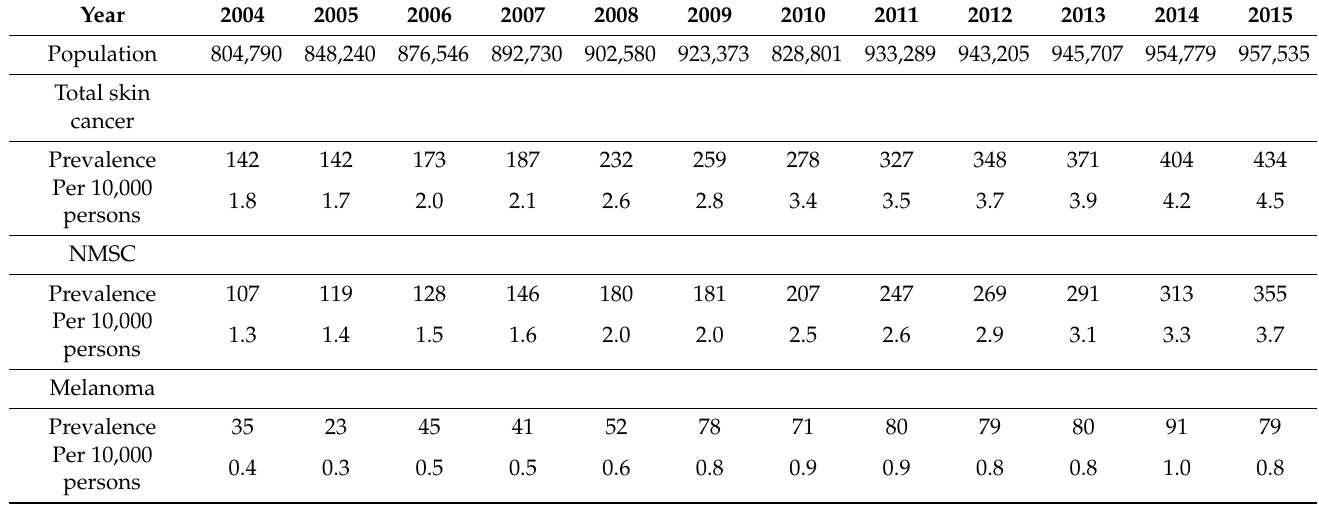
Table 1. Estimated prevalence rates of total skin cancer, NMSC, and melanoma (per 10,000 persons) during the study